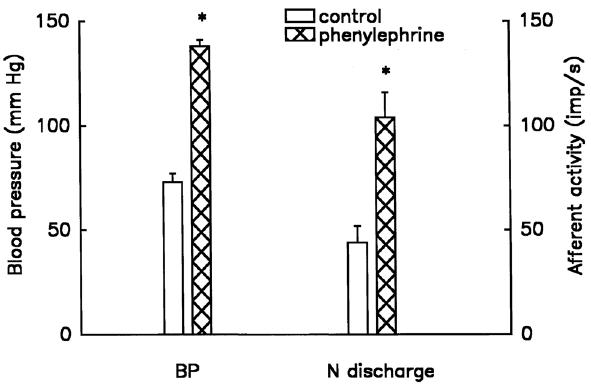
Figure 6. Response of baroreceptor units (n = 11) to intravenous injection of phenylephrine (10 mM, 0.2 ml). Blank and hatched bars are control and after phenylephrine, respectively. *p <